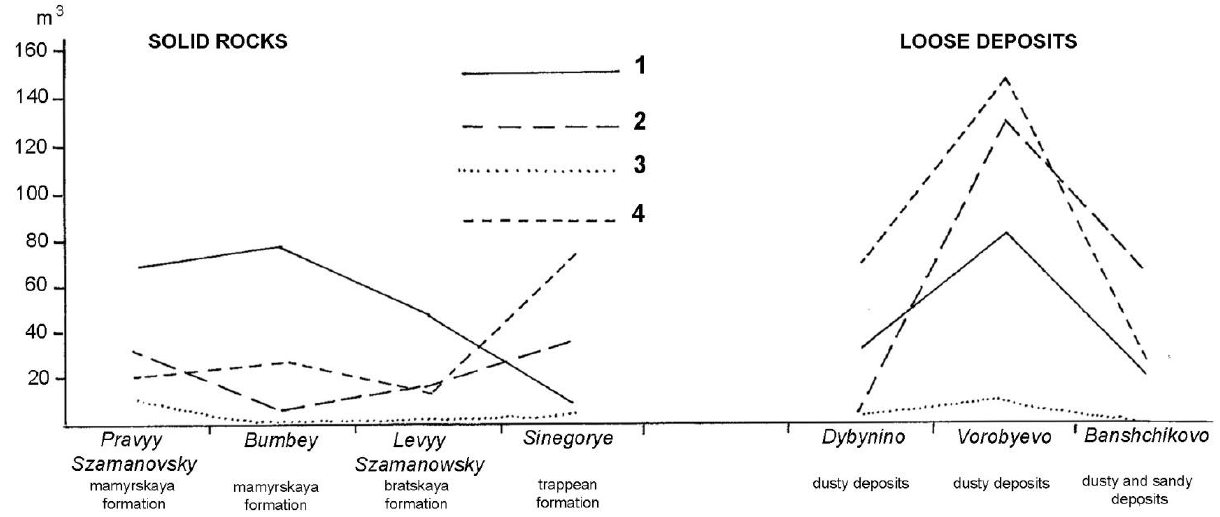
Fig. 6. Total amount of reworked material in the observation sites (period 1977–1990) accumulation (after Tashlykova, 2010, changed) 1 – water side degradation; 2 – subaqueous degradation; 3 – water side accumulation; 4 – subaqueous